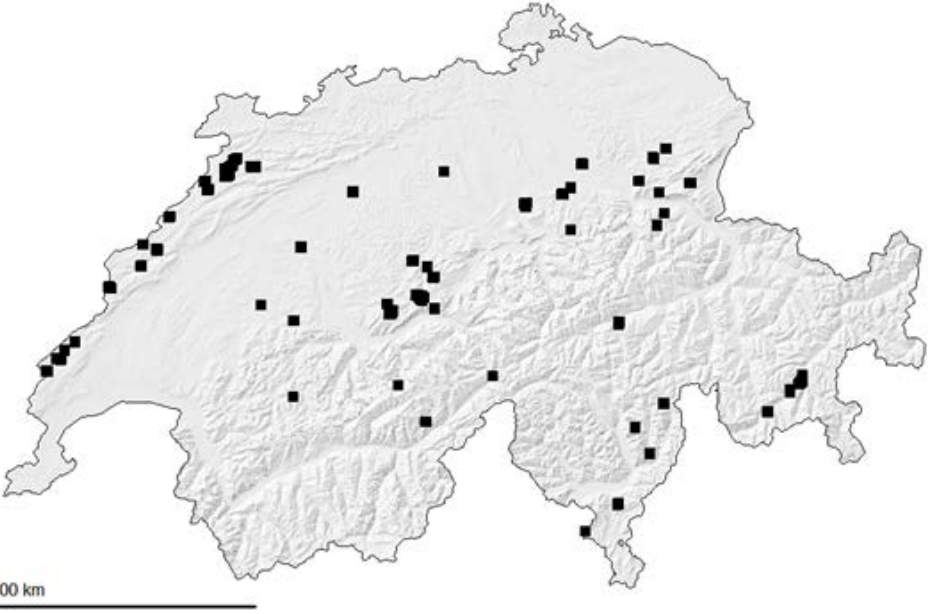
Figure 1. Distribution of the 80 bog sites studied in